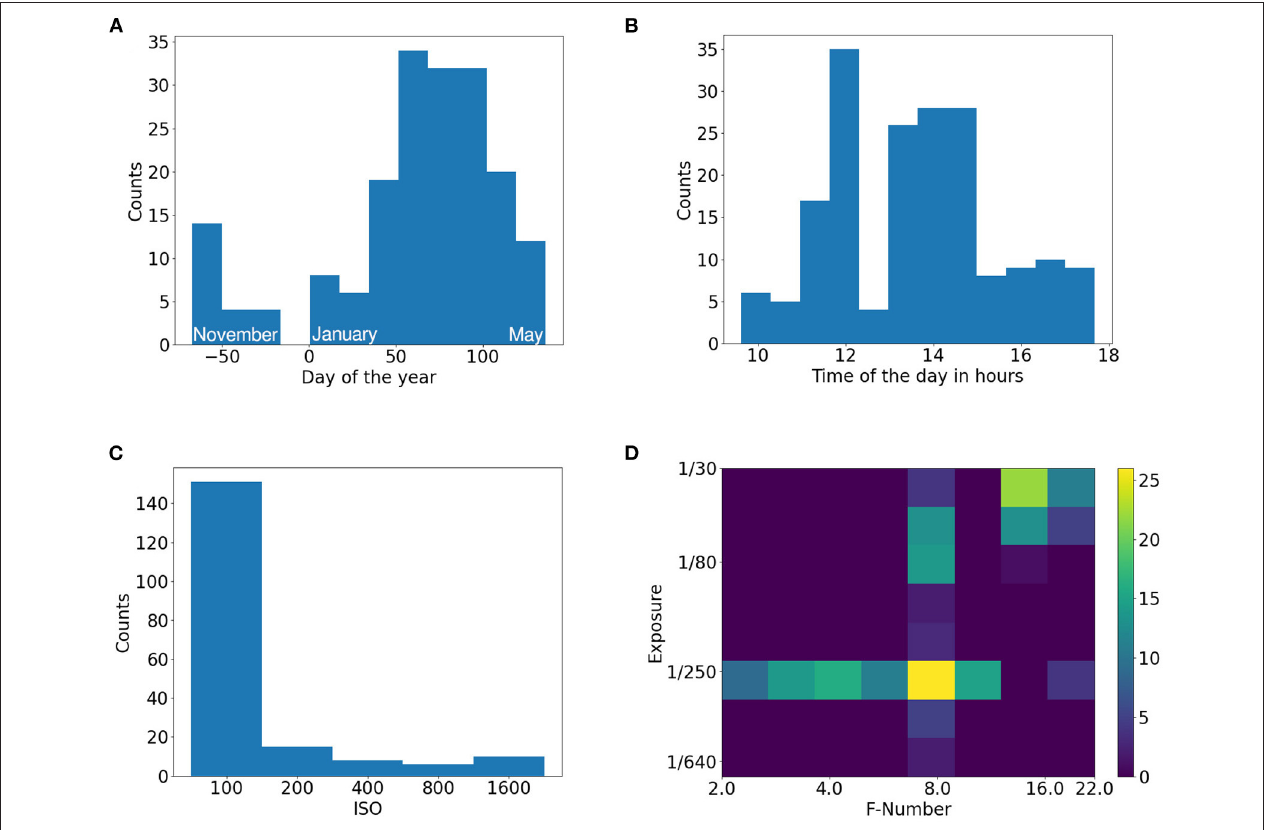
FIGURE 2 | Histograms of EWS dataset. (A) Day of the year, (B) Time of the day, (C) ISO settings, (D) Exposure and F-number settings